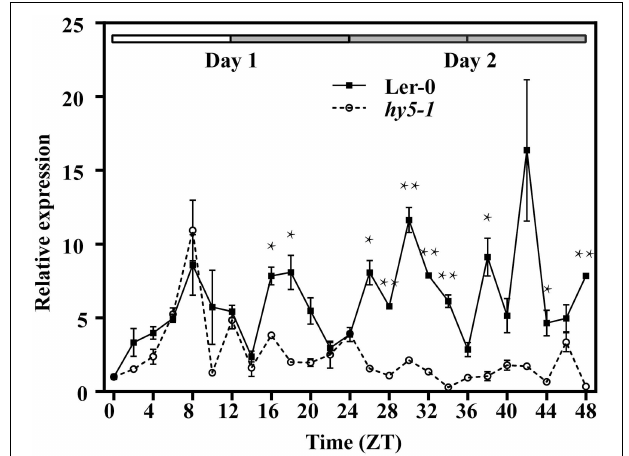
FIGURE 4 | Diurnal expression of the luciferase gene ( LUC ) driven by the 1400 bp upstream fragment of the QH6 promoter, with the G-box intacted (1400::LUC) or mutated (1400M::LUC). Arabidopsis thaliana Col-0 plants were transformed by 1400::LUC and 1400M::LUC constructs. The activity of luciferase expressed was quantified by measuring the radiance emitted and captured in 4min by IVIS Lumina XR Imaging System (Caliper Life Sciences). Plants were growing in standard 12h/12h light/dark conditions. ZT is Zeitgeber time and here represents time from light on at dawn. Filled and open bars indicate subjective days and nights. Data represent means ± SD. The differences of expression levels were assessed by unpaired Student’s t -test. * p < 0 . 05 and ** p < 0 . 01 in 1400::LUC vs. 1400M::LUC transgenic Col-0 plants.